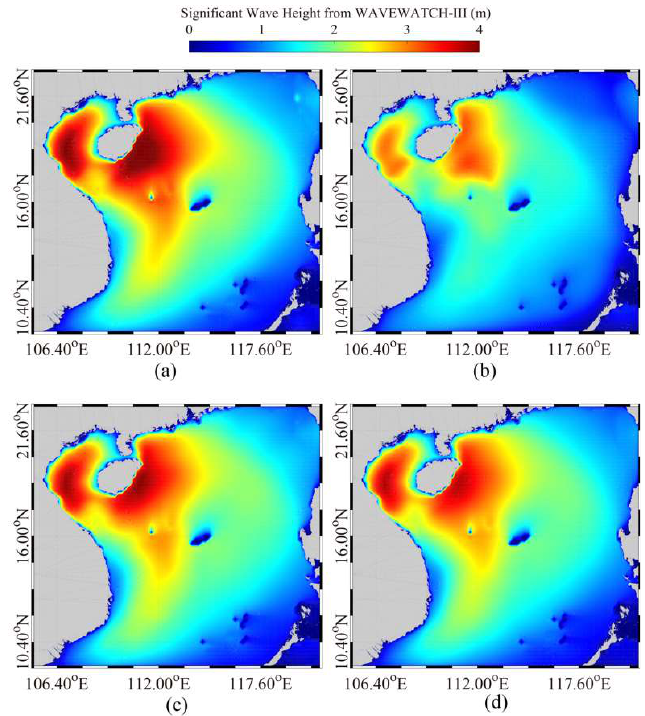
Figure 4. The simulated SWH maps using the three packages of nonlinear term for quadruplets wave–wave interactions in Typhoon Doksuri at 12:00 a.m. UTC on 15 September 2017. ( a ) simulated results using the Discrete Interaction Approximation (DIA) package; ( b ) simulated results using the Webb–Resio–Tracy (WRT) package; ( c ) simulated results using the GMD1 package; ( d ) simulated results using the GMD2 package.